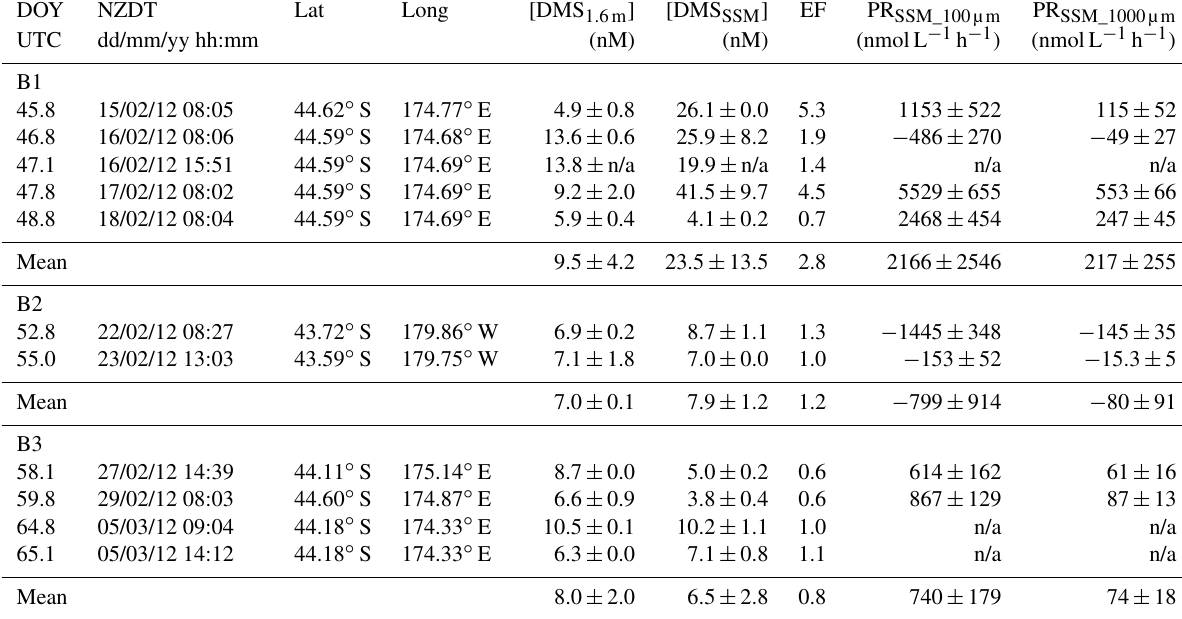
Table 1. Sea-surface microlayer station variables: DMS concentrations in the SSM ([DMS SSM ]), collected using the plate method, and in seawater at 1.6m depth ([DMS 1 . 6m ]); DMS enrichment factor (EF); and DMS production rate (PR SSM ) for a 100 and 1000µm thick SSM. EF is the ratio of [DMS SSM ] and [DMS 1 . 6m ], with an EF >1 indicating enrichment and <1 depletion. Production rates are averages for the period 3h before and 5h after SSM sampling. Day of year (DOY) 1 is 1 January 00:00:00. [DMS] errors are 1SD from the mean of duplicate